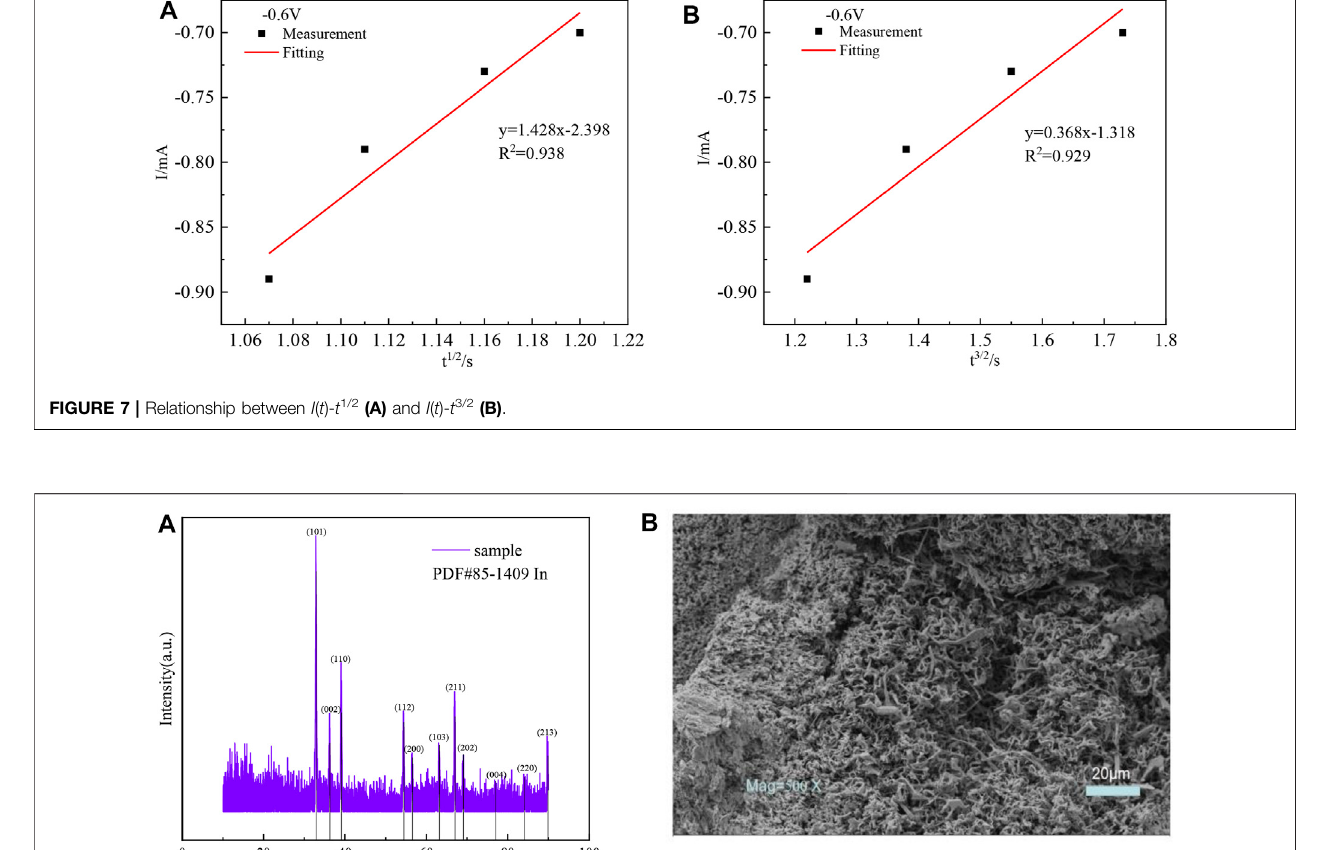
Frontiers in Chemistry |